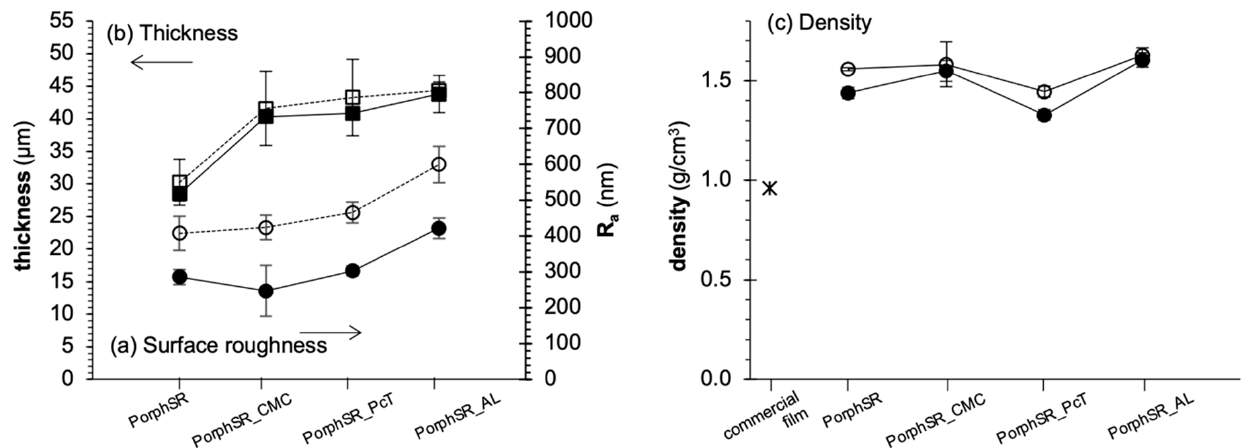
Figure 4. Measured morphological features of the produced films: (a) arithmetic mean surface roughness (R a ); (b) film thickness; (c) material density. (Clear symbols: compositions without glycerol; full symbols: samples with glycerol; ∗ : reference commercial film.)